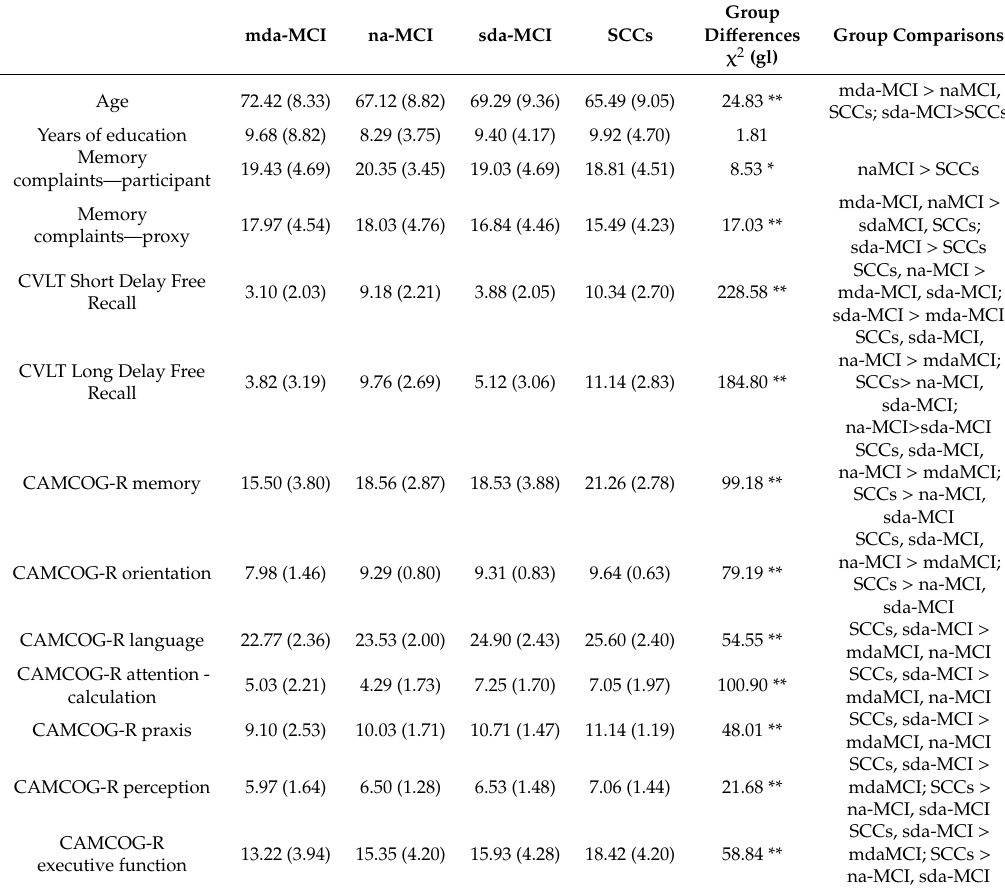
Table 1. Mean values and standard deviations (in parentheses) of the demographic and cognitive measures in each group at